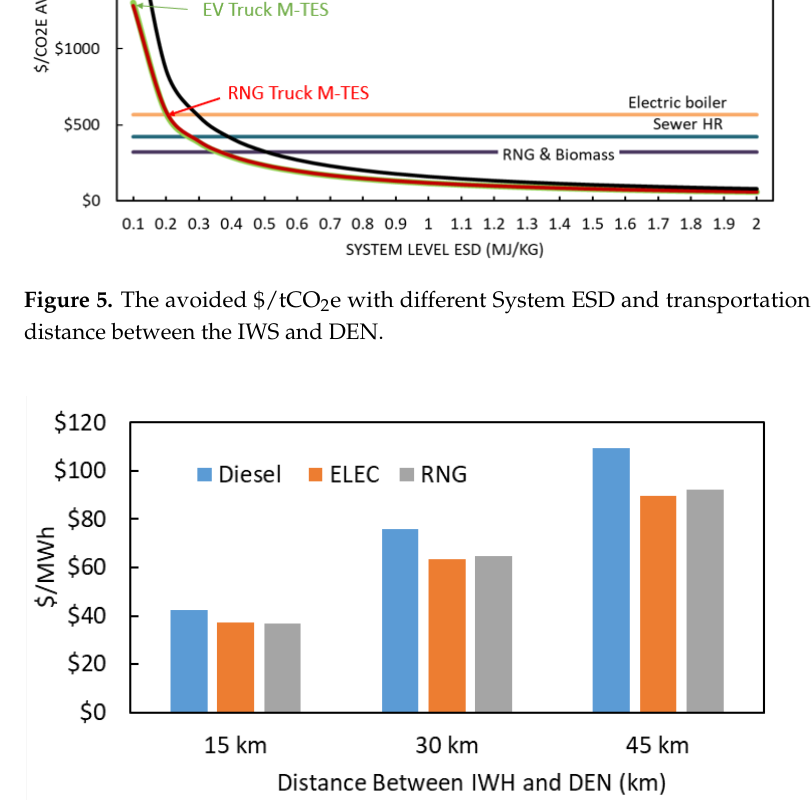
Figure 7. The levelized cost of diesel truck M-TES ($/MWh) varies with a distance and system ESD of 0.7 MJ/kg and other Surrey DEN low-carbon sources cost estimation. Similarly, Figure 8 shows the cost of avoided emissions ($/tCO 2e Avoided) for the considered truck modes with variable distances between the IWH source and the DEN. Since diesel has the highest $/tCO 2e , it was further compared with other low carbon sources in Figure 9. Figure 8. The cost of avoided CO 2 e with different IWH locations and truck modes.